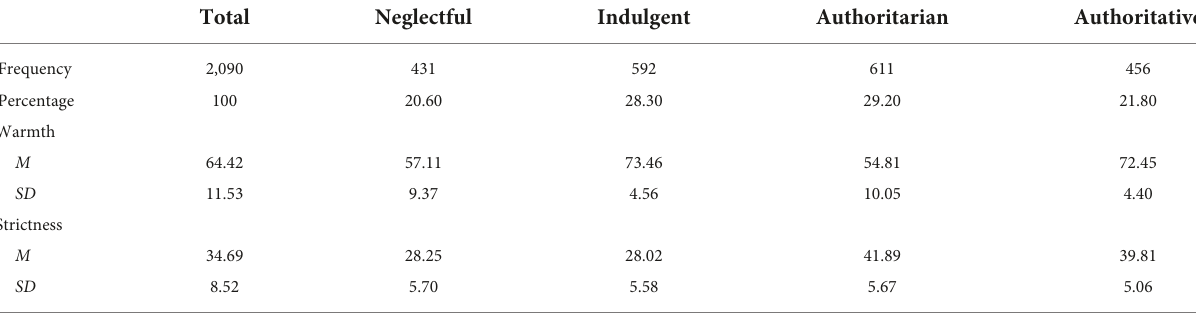
TABLE 1 Distribution of participants by parenting style, mean scores, and standard deviations for the main parenting dimensions.